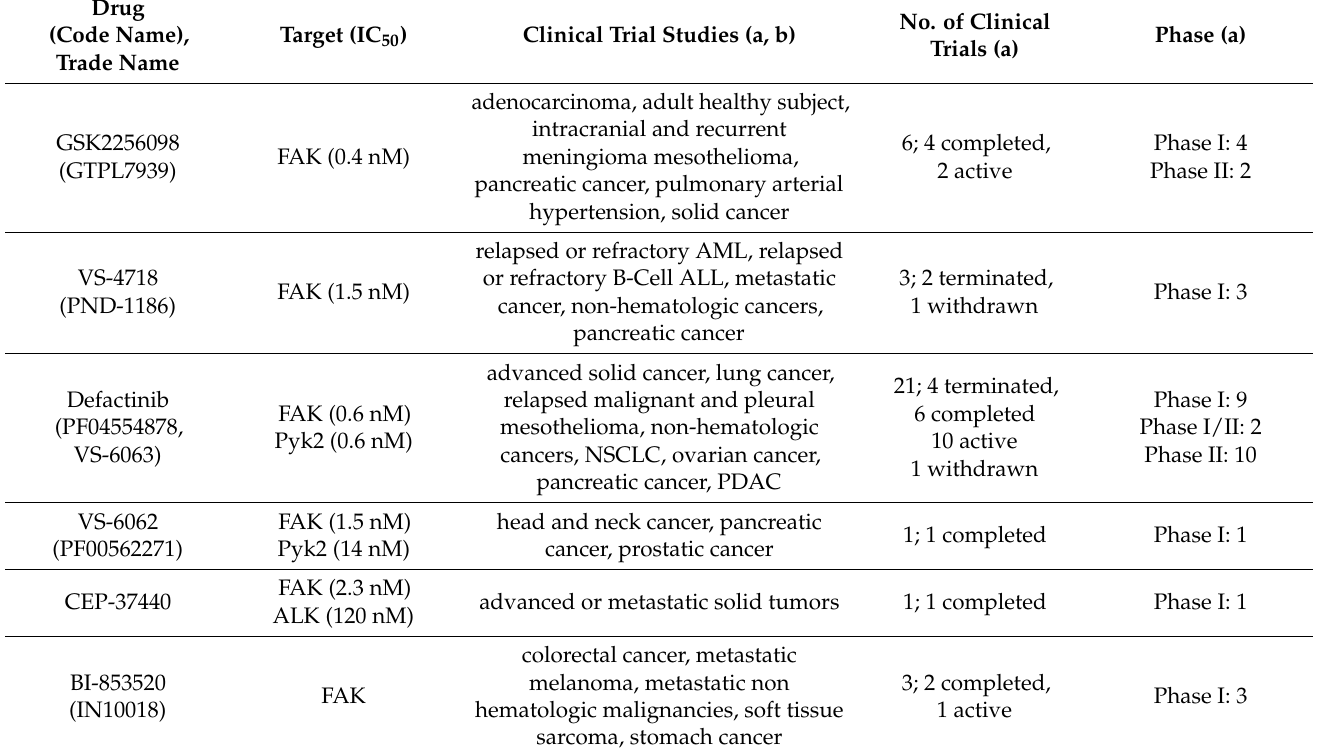
Table 1. Summary of FAK inhibitors in clinical